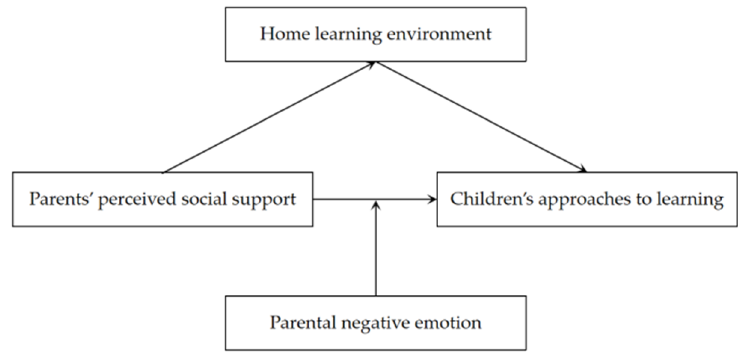
Figure 1. The proposed